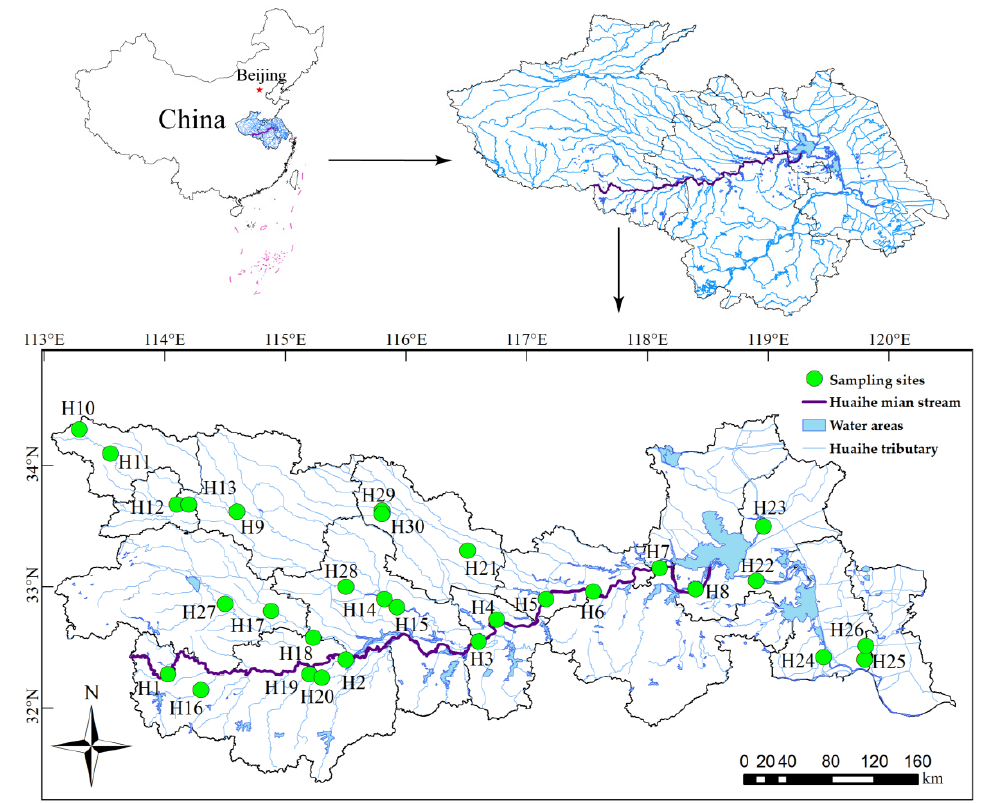
Figure 1. Distribution of sampling sites in the Huaihe River Basin.